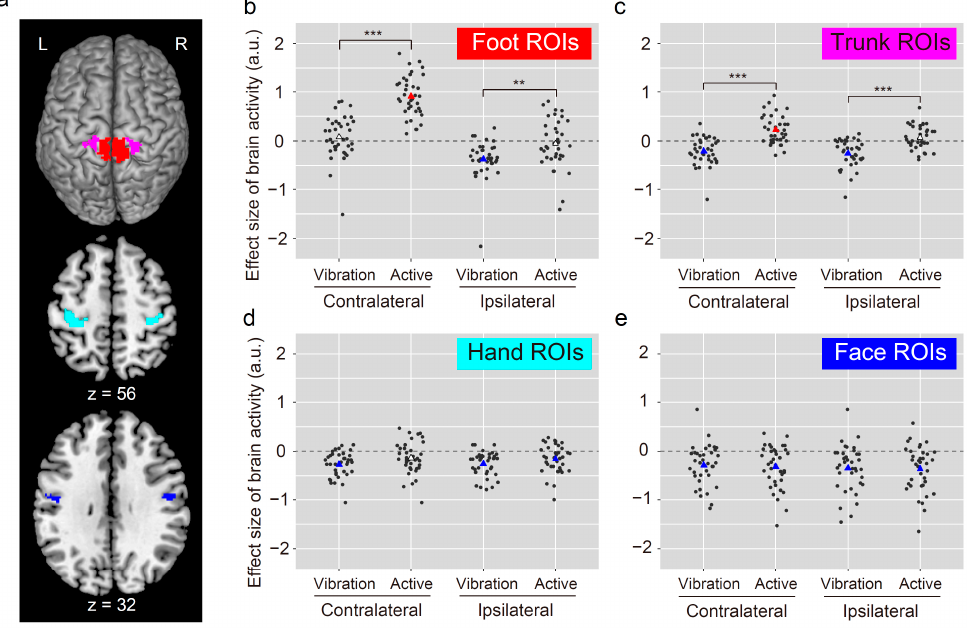
Figure 3. Regions of interest (ROIs) and individual brain activity within each ROI during both tasks. ( a ): The foot (red), trunk (magenta), hand (cyan), and face ROIs (blue) in bilateral M1. ( b ): We plotted individual effect sizes of brain activity in the contralateral (left) and ipsilateral (right) foot ROIs for each task. Similarly, ( c – e ) present data obtained from the trunk, hand, and face ROIs, respectively. Plotted points are horizontally jittered to avoid overplotting. Triangles represent the mean across participants. Red and blue triangles indicate that the mean was significantly greater or lesser than 0 (dotted line), respectively. Asterisks indicate significant between-task differences (** p < 0.01, *** p < 0.001 with Bonferroni correction). Abbreviations: L, left; R, right; a.u., arbitrary unit.